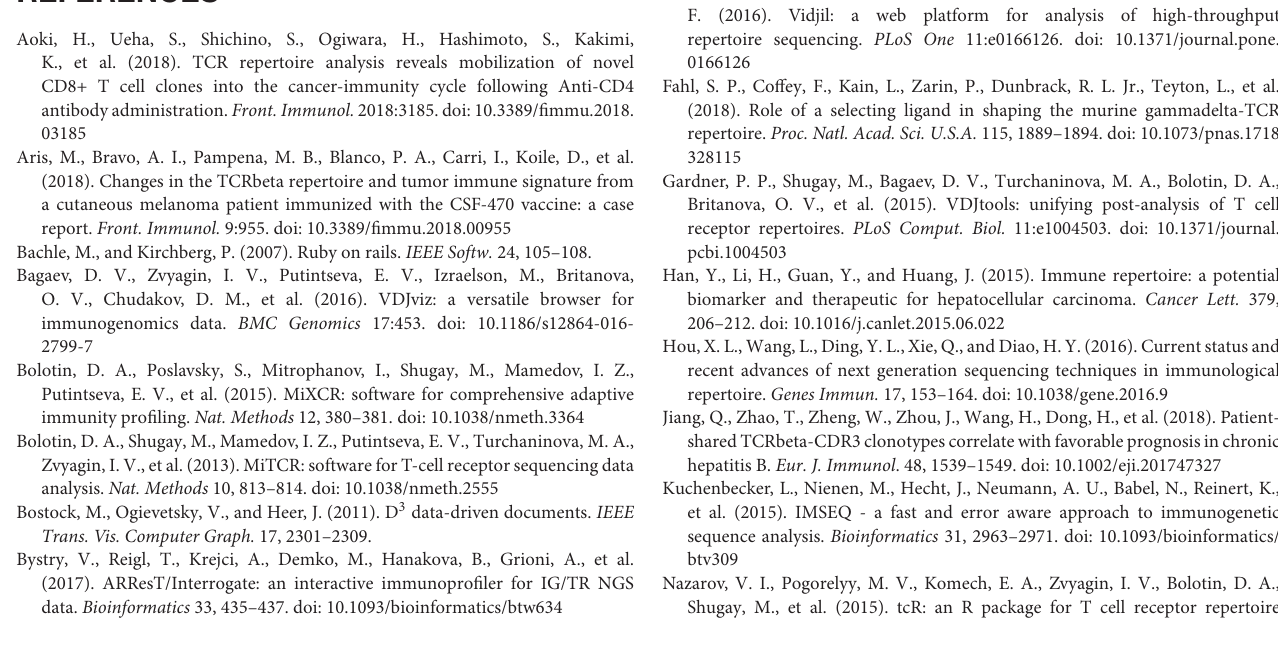
FIGURE S2 | Example analysis of mouse tumor dataset by using VisTCR. (A) Clonal homeostasis analysis. (B) Bio-diversity analysis by using Shannon diversity